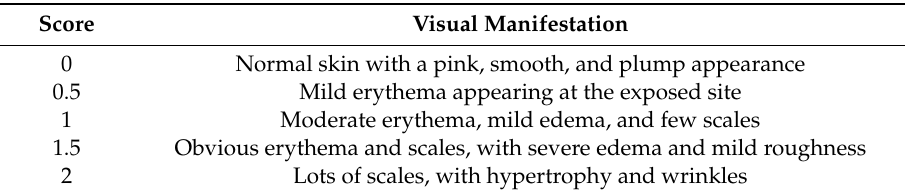
Table A1. LSR (local skin response) grading